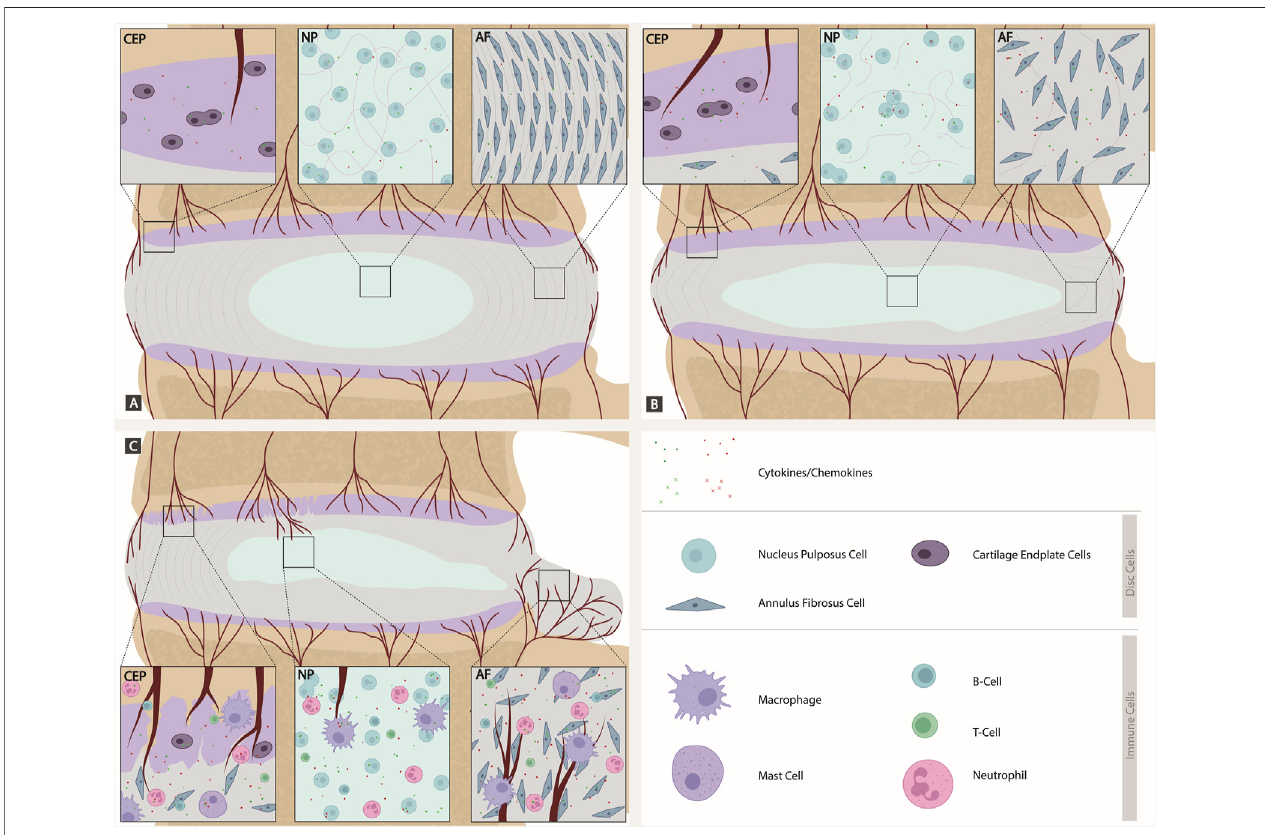
FIGURE2| Comparisonofahealthy,degenerated,andherniatedIVDdiscs(focusedoncellular involvement). (A) IntactIVD:Nativedisccellsproduceaplethoraof cytokines and chemokinesexpressing the corresponding receptors and maintaining homeostasisin a para and autocrine manner. The CEP is intact with blood vessels. The NP has a high number of proteoglycans. AF cells aligned. (B) Degenerated IVD: Shift to catabolic environment. Cytokines are expressed by disc cells themselves. The CEP has ahigher amount of blood vesselsthan in the intact IVD. Proteoglycan number decreases in theNP. In the AF, there isa loss ofalignmentand support forAFcells. (C) HerniatedIVDwithcrackinCEP:AssoonastheAForCEPisrupturedduringinjuryordiscdegeneration,arouteformigrationofimmunecellsintotheIVD isprovided.Immunecells,includingTcells,Bcells,macrophages,neutrophilsandmastcells,contributetoanin fl amedenvironmentwithinthedisc,furtherincreasingthe cytokine and chemokine expression and leading to a viscous circle of in fl ammatory driven catabolism. A crack in CEP allows blood vessels to grow into the AF and NP. The AF herniates/bulges, which is where blood vessel in-growth primarily occurs.